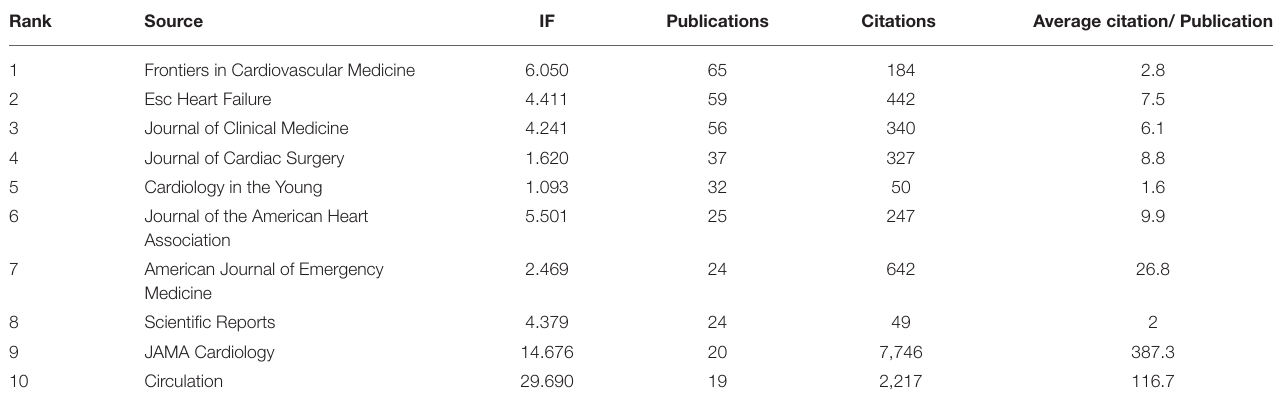
TABLE 4 | Top 10 journals of COVID-19-mediated cardiac disorder.